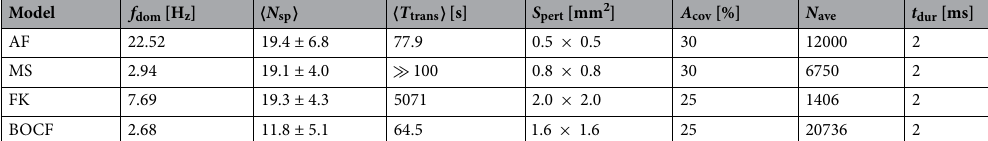
Table 1. This table lists for all investigated cell models the dominant frequency f dom , the average number of spiral waves (cid:31) N sp (cid:30) , the average transient lifetime (cid:31) T trans (cid:30) , the spatial size of single AVEs S pert , the relative fraction of the simulation domain covered with AVEs A cov , the absolute number of AVEs N ave , and the temporal duration of single stimuli t dur .